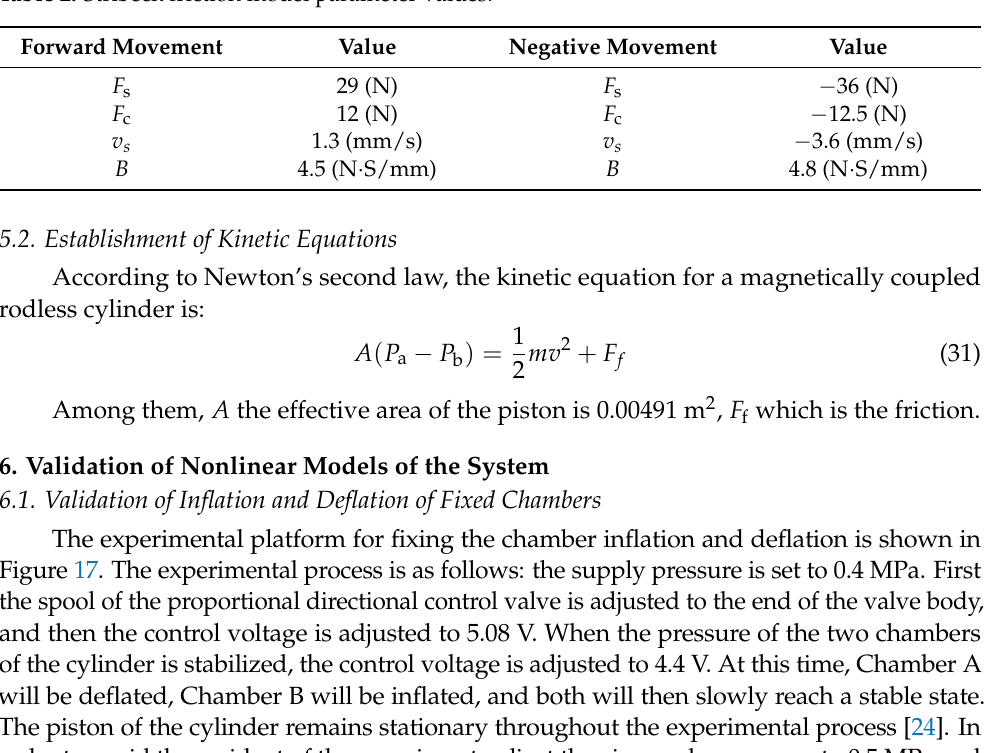
( b ) Figure 18. Filling simulation and experimental diagram of fixed chamber: ( a ) Chamber A deflating; ( b ) Chamber B inflating. 6.2. Positioning Experiment Verification of Nonlinear Model Systems According to the pneumatic circuit shown in Figure 1, the nonlinear model is verified by PID-controlled positioning experiments. The air supply pressure is constant at 0.52 MPa, and given a step signal, the target position is 58. The results of the experiment and simulation are shown in Figure 19, because the cylinder inflation requires a certain reac- tion time during the experiment, and the simulation is carried out under ideal conditions, so the experimental reaction time will be slower than the simulation. However, the exper- iment is consistent with the trend of the simulation curve.